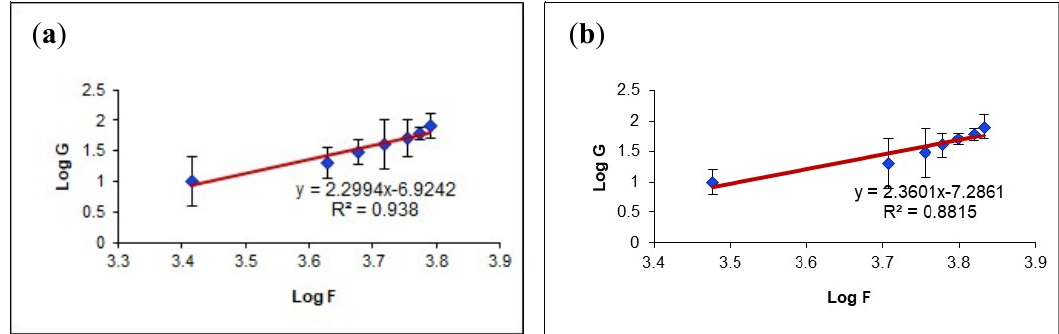
Figure 5. Plots of the logarithm of the shear rate (G) versus the logarithm of the shear stress (F) for ( a ) plain HPC hydrogel